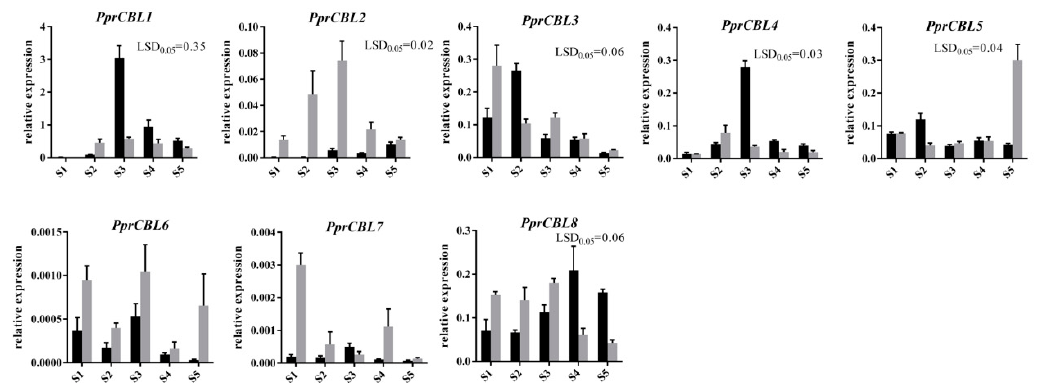
Figure 5. Expression profiles of peach CBL and CIPK genes during fruit development of “Zhong you 4” and “Li Xia Hong”. The x -axis “S1” represents the first exponential growth stage; “S2” represents the pit hardening stage; “S3” represents the second exponential growth stage; “S4” represents the fruit ripening stage; and “S5” represents the full ripening stage. The y -axis represents the relative expression of CBL and CIPK members to the internal reference gene PprTEF2 . The error bars represent the ± SE of three biological replicates. Any difference between two group means greater than LSD 0.05 is considered significantly different.